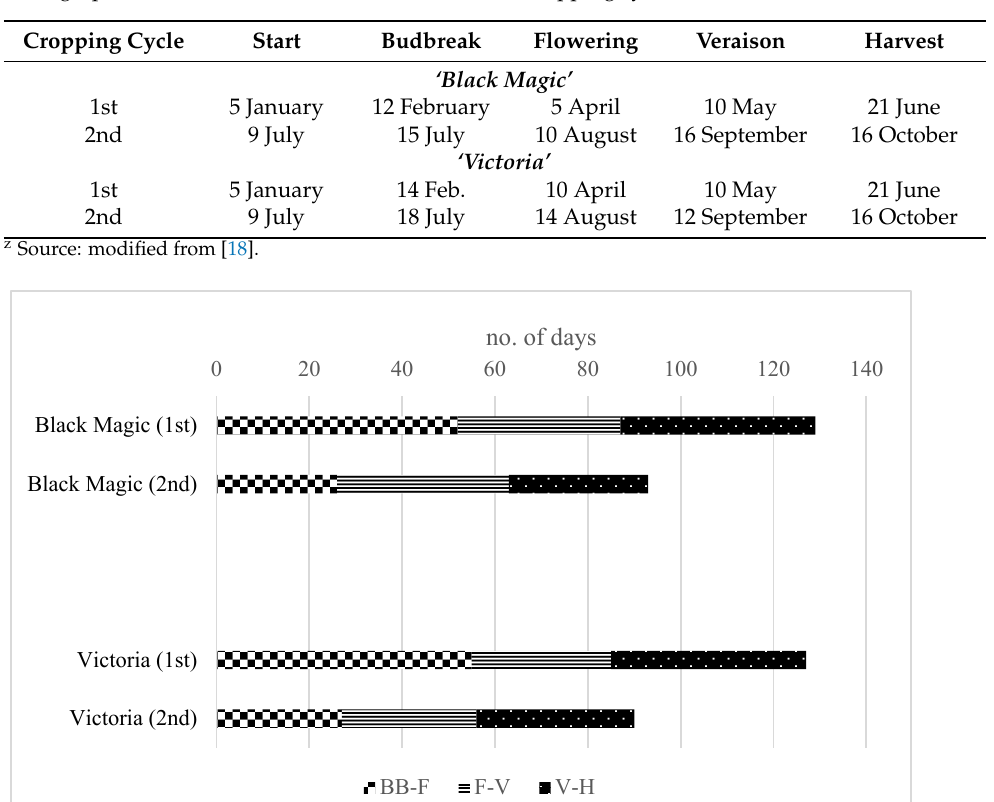
Table 3. Vine phenology during two consecutive cropping cycles in ‘Black Magic’ and ‘Victoria’ table-grape soil-less cultivation submitted to double-cropping system z .